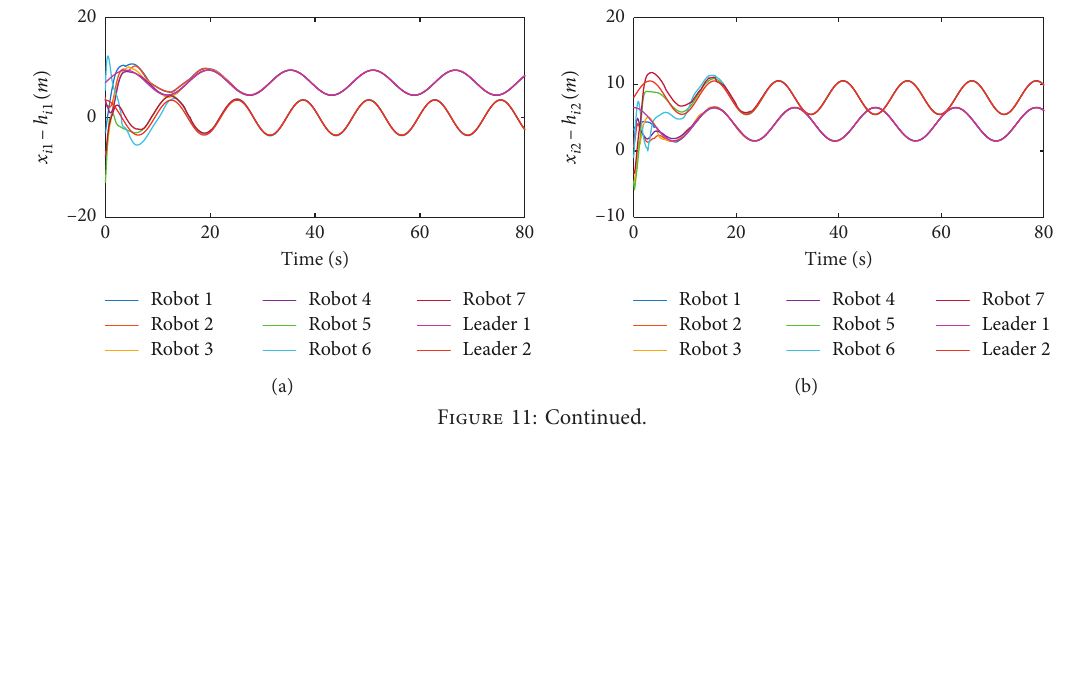
􏽥 x i 2 (d) in Example 2.